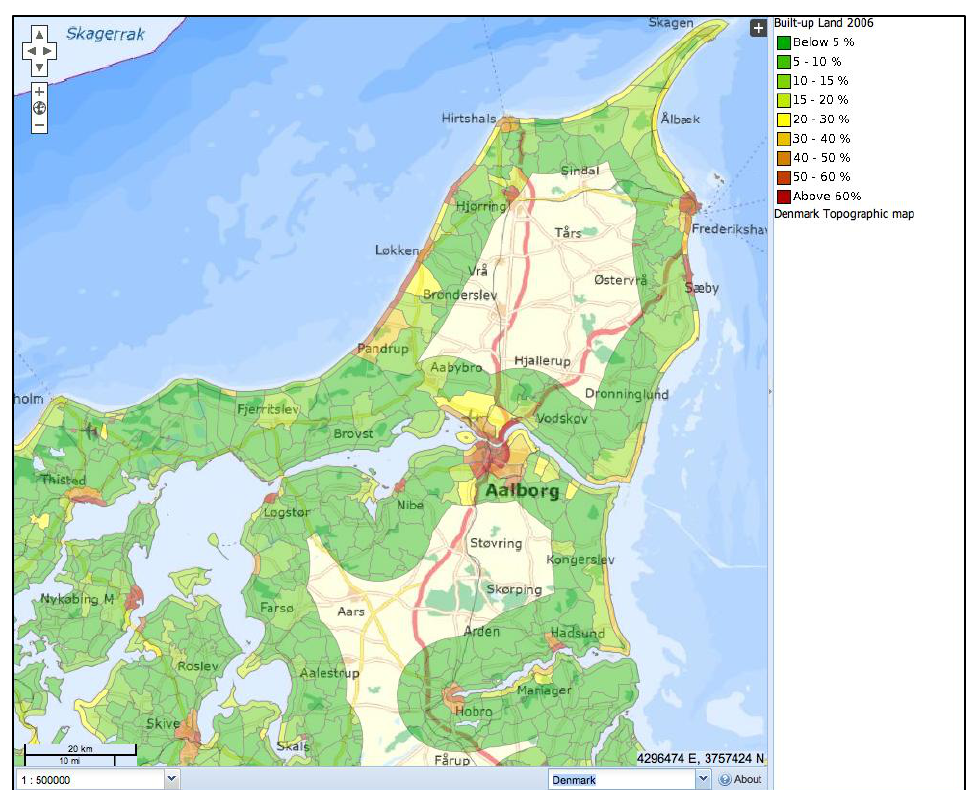
Figure 7. Indicator example—Built-up land in